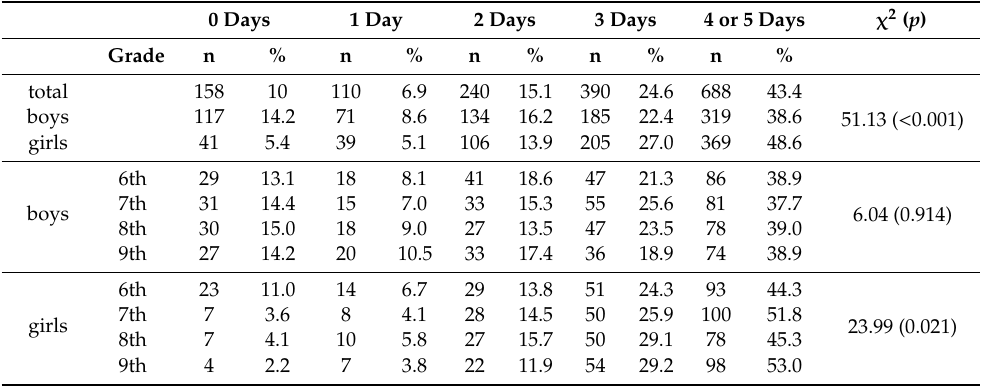
Table 2. Perceived active commuting to school among Czech adolescents according to gender and class